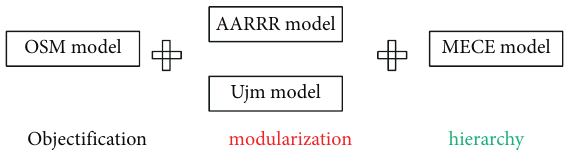
Figure 2: Development model of numerical